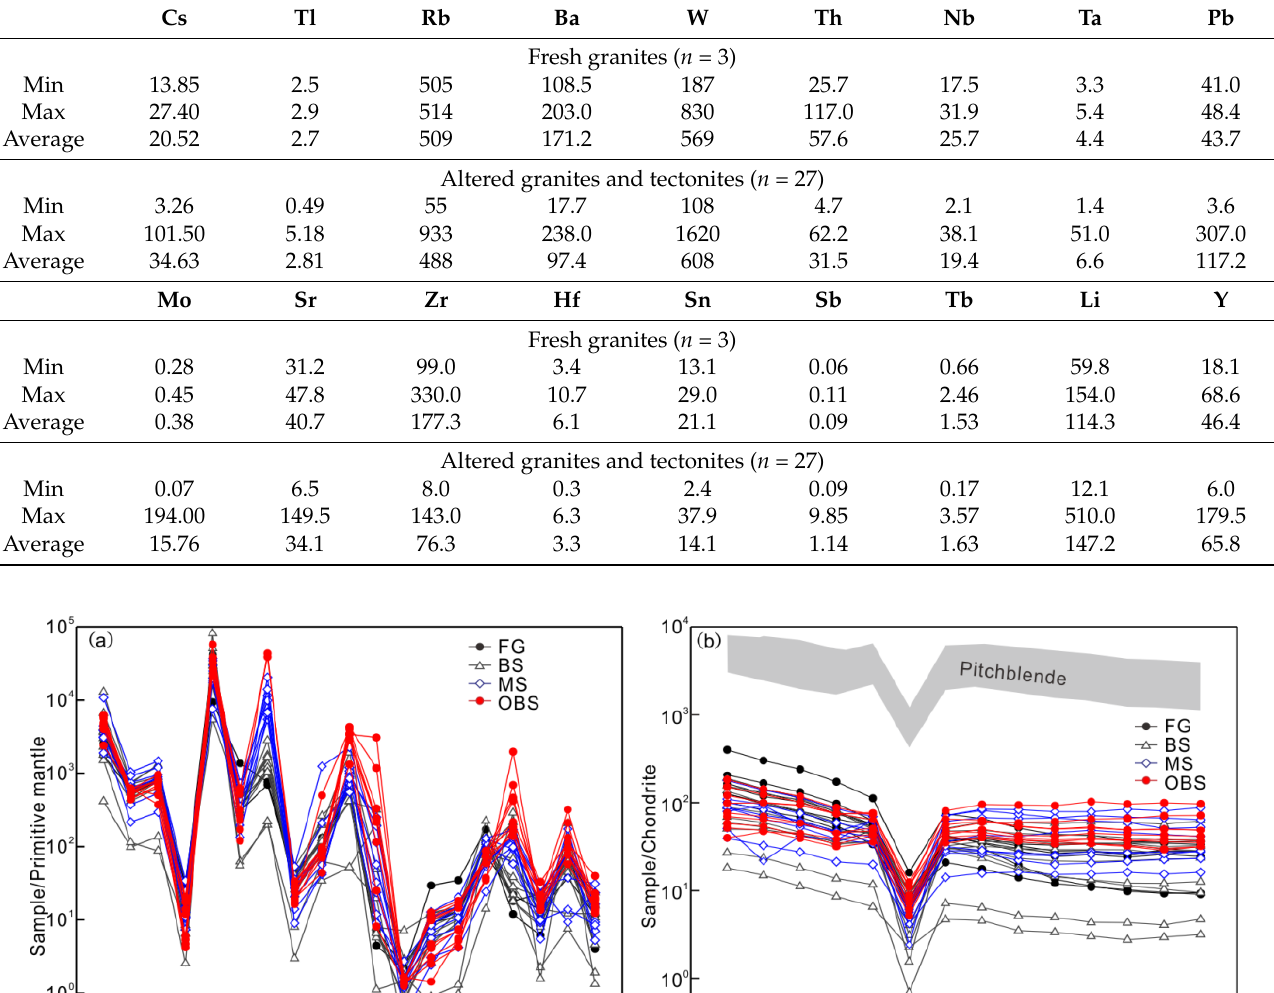
Table 3. Geochemical summary of selected trace elements and REEs (ppm) of SJOF granite samples.